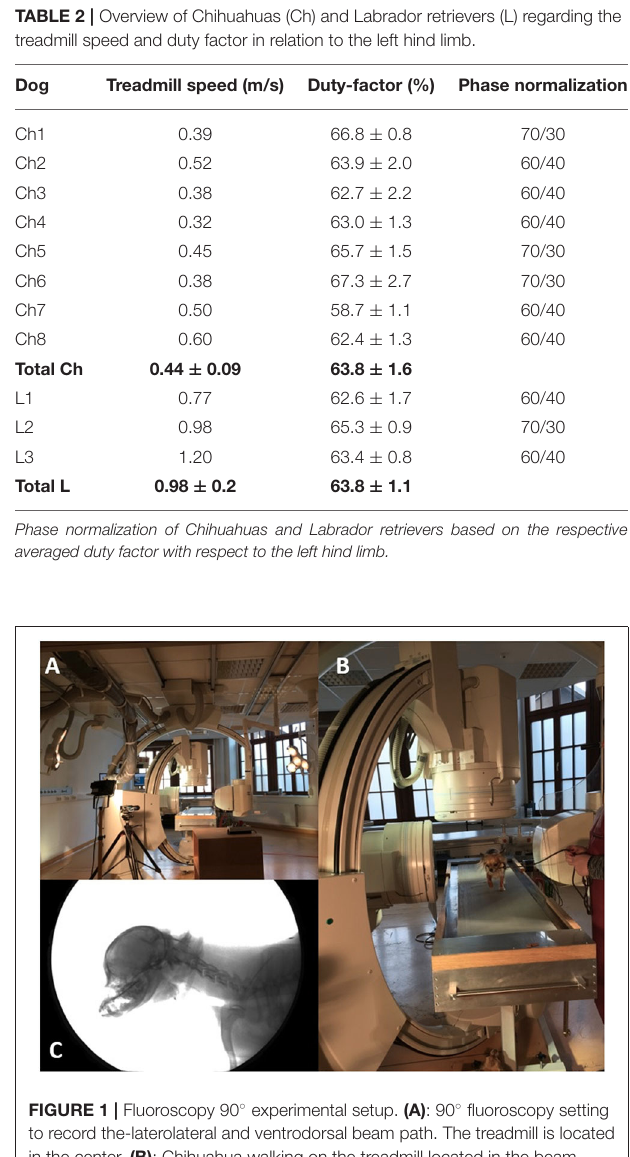
Biplanar X-ray videos of each dog during walking were